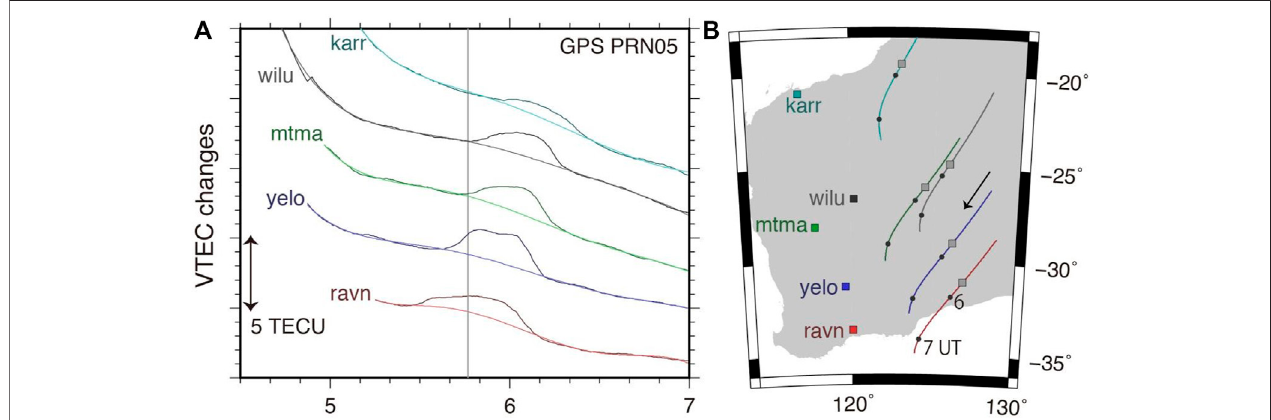
FIGURE5| AnLSTIDwasobservedusingGPSPRN05inWesternAustraliapropagatingnorthwardwithaspeedof~0.6 km/s.In (A) ,weplottheVTECtimeseries at fi vestations,shownwithsquaresin (B) .Thecolorsofthecurvesin (A) correspondtostationsandSIPtracksin (B) .CirclesontheSIPtracksindicatehourlytimemarks and grey squares show SIP positions at the time of the earthquake. Reference curves in (A) are estimated as polynomials of degree fi ve excluding the time periods in fl uenced by LSTID.